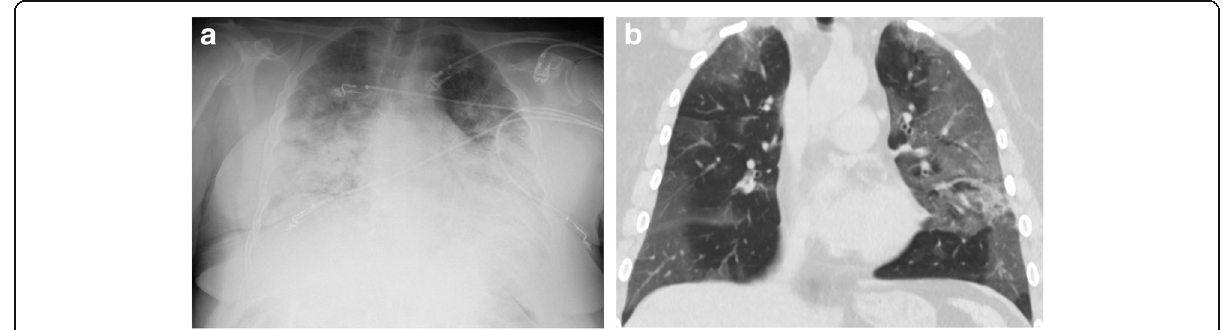
Fig. 3 a and b Imaging in COVID-19 showing widespread bilateral interstitial and airspace opacities (3B: “ Courtesy of Dr. Maurice Henkel ” )